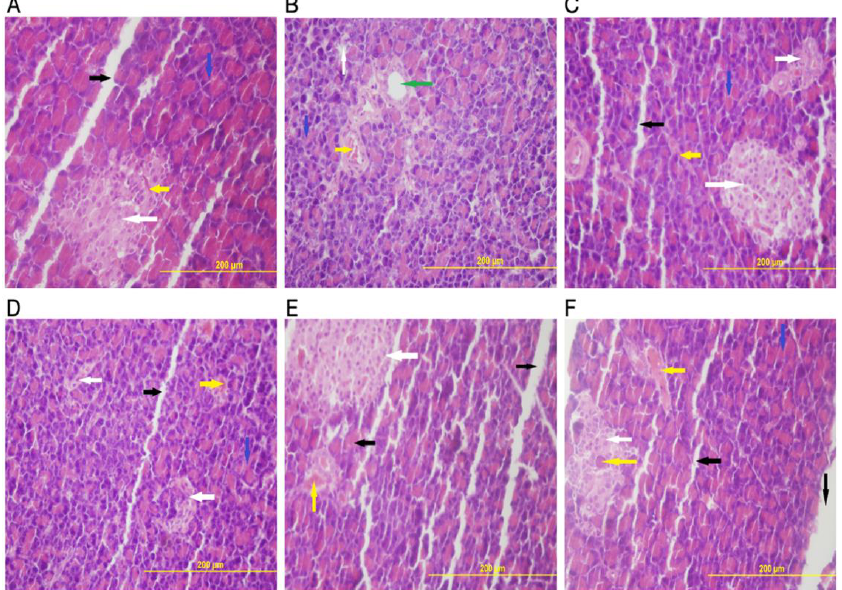
Figure 6. Photomicrographs of pancreatic tissue of controls and treated experimental animals. ( A ) The control group showed a healthy islet of Langerhans (endocrine cells) (white arrow), a compact glandular cells-exocrine portion with basal nuclei (blue arrow), and blood vessels (yellow arrow). ( B ) Diabetic group (STZ + HFD) showing damaged endocrine cells (white arrow), enlarged interlobular duct (green arrow), disturbed glandular cells with dilated interlobular blood vessels (yellow arrow) and perilobular fibrosis (blue arrow). ( C ) STD GLB group showing recovered endocrine cells (white arrow), with blue arrows indicating near-normal glandular cells and black arrows showing intralobular duct. ( D ) Treatment with 200 mg/kg TME showed recovering endocrine cells still having perilobular fibrosis, but not as the diabetic control group. ( E ) represents 400 mg/kg TME with recovered endocrine cells (white arrow), and blood vessels (yellow arrow) with a near-normal intralobular duct. ( F ) shows treatment effects with UFN closely similar to that produced by 400 mg/kg of TME treatment. H&E × 400. STZ; streptozotocin HFD; high-fat diet, STD GLB; standard glibenclamide, TME; total methanol extract, UFN;